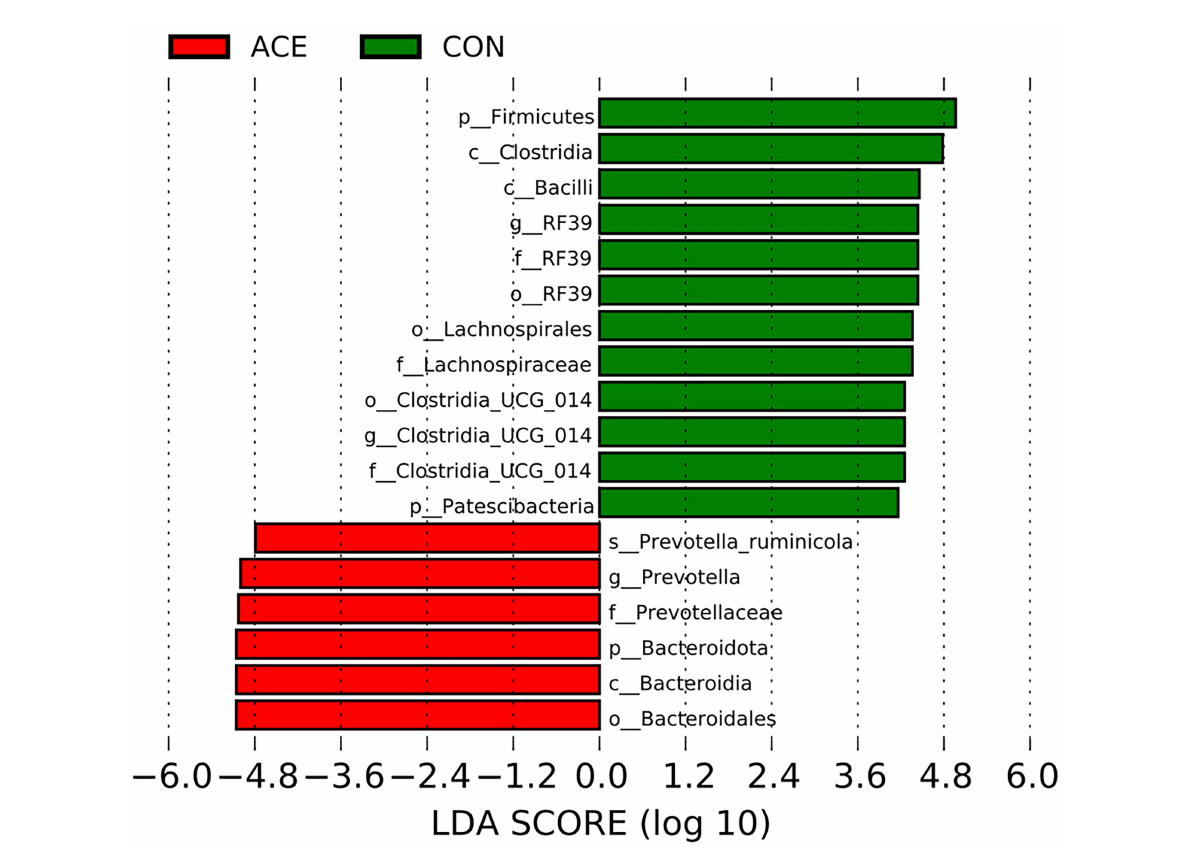
FIGURE 3 Histograms of LDA scores >4 were calculated for each taxonomic unit from phylum to genus. LDA scores indicate differences in relative abundance between two communities, with an exponential multiplicative change of 10 indicating significant differences between